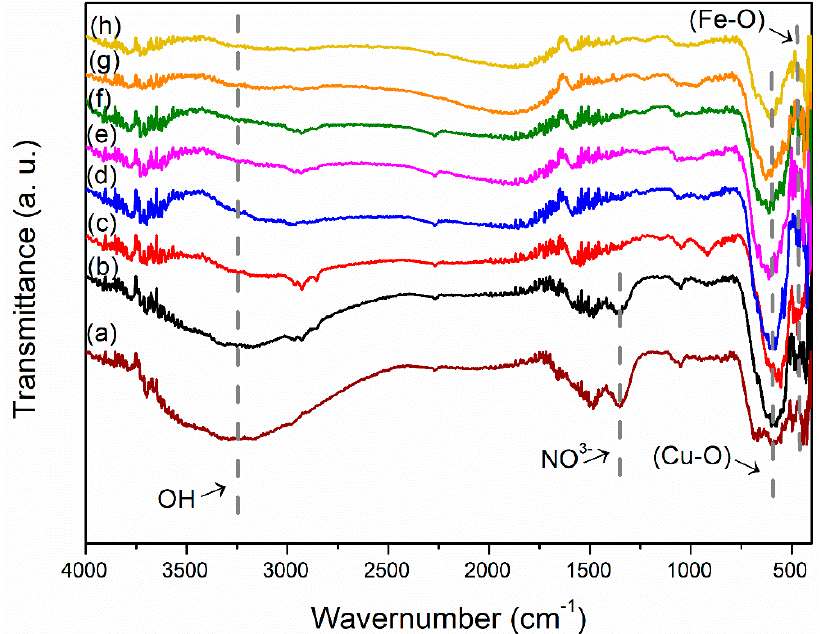
Figure 4. The FTIR spectra of CuFe 2 O 4 : ( a ) 400, ( b ) 500, ( c ) 600, ( d ) 700, ( e ) 800, ( f ) 900, ( g ) 1000 and ( h ) 1100 °C . ( h ) 1100 ◦